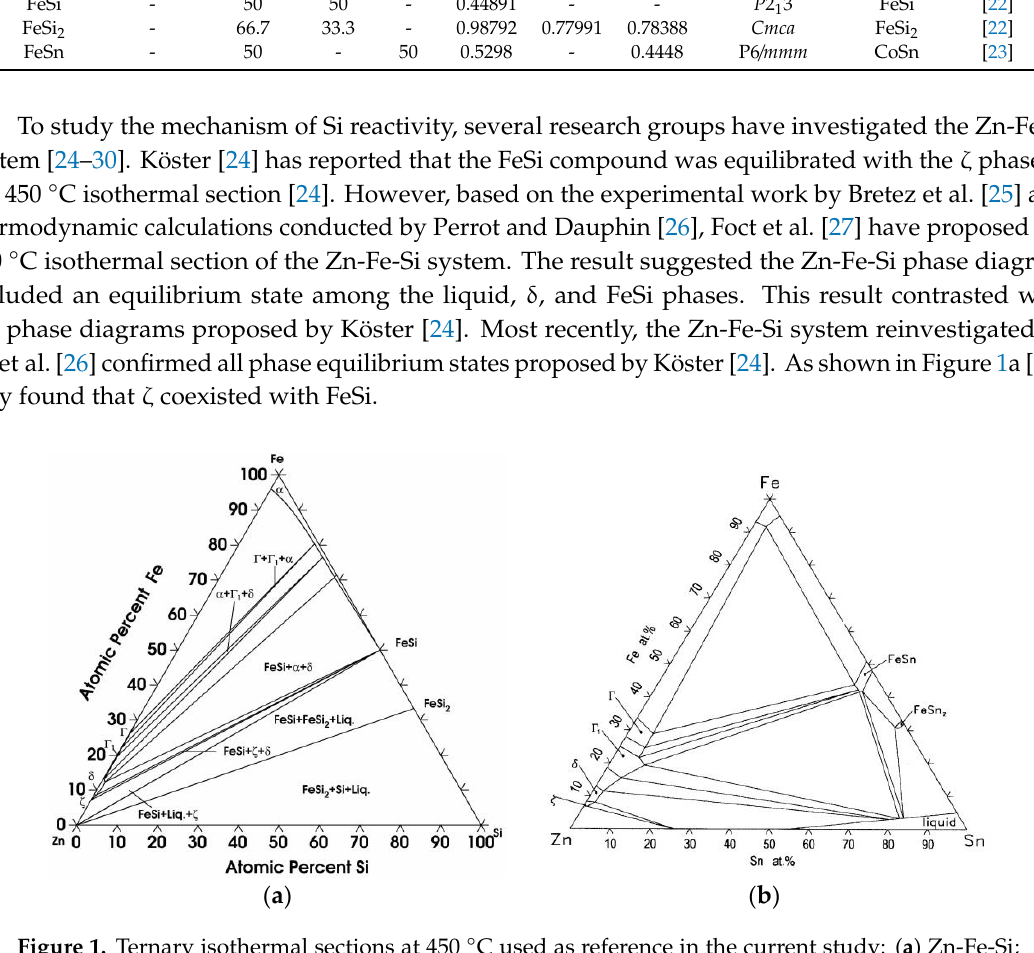
Table 1. Crystallographic data of the intermetallic compounds relevant to the present work. Compositions, at.% Lattice Parameter, nm Phase Zn